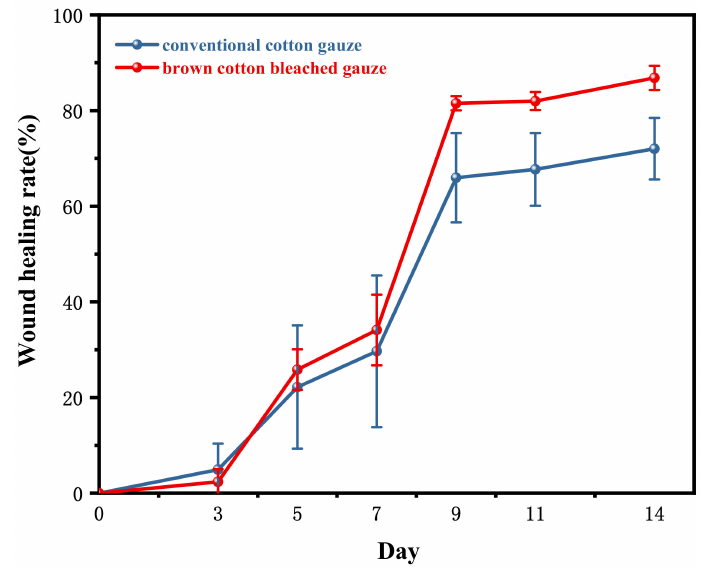
Figure 5. Wound healing rate in